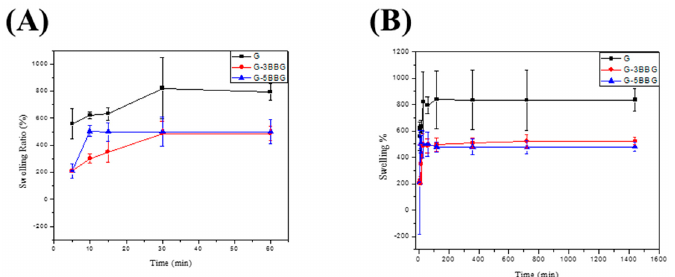
Figure 8. The profile of swelling capacity versus time of the hydrogel composites in deionized water. In each case, the swelling capacity is measured after ( A ) 5, 10, 15, 30, 60 min, ( B ) 5 min, 10 min, 15 min, 30 min, 60 min, 2 h, 6 h, 12 h, and 24 h. The error bar represents the standard deviation based on at least three different measurements performed by three different experimenters.